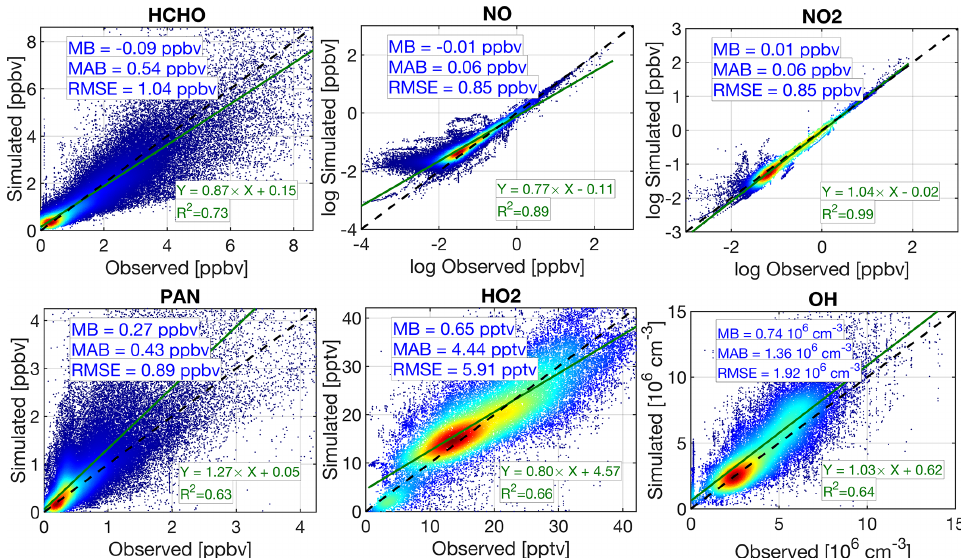
Figure 2. The comparisons of the observed concentrations of several critical compounds to those simulated by our F0AM box model. Each subplot contains the mean bias (MB), mean absolute bias (MAB), and root mean square error (RMSE). The least-squares fit to the paired data and the coefficient of determination ( R 2 ) are also individually shown for each compound. Note that we do not account for the observation errors on the x axis. The concentrations of NO and NO 2 are